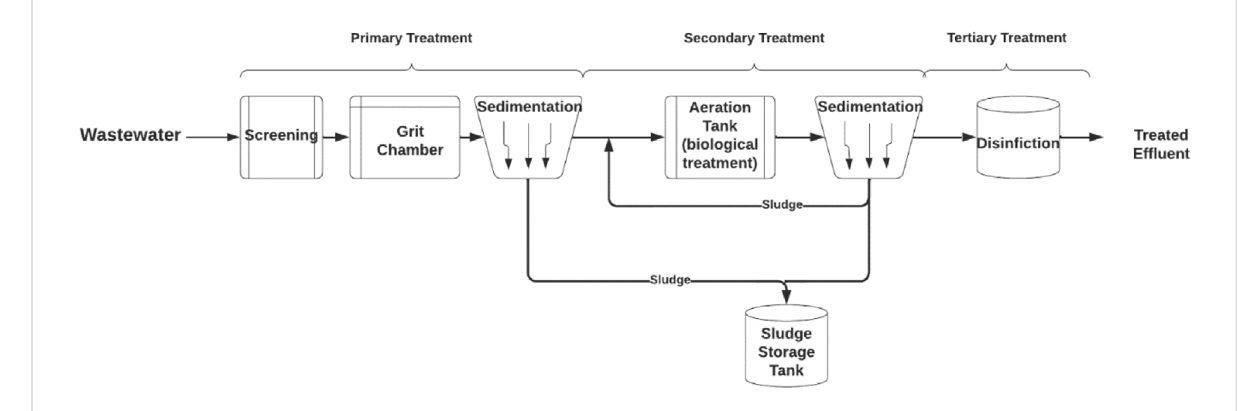
FIGURE 1 Wastewater treatment process.